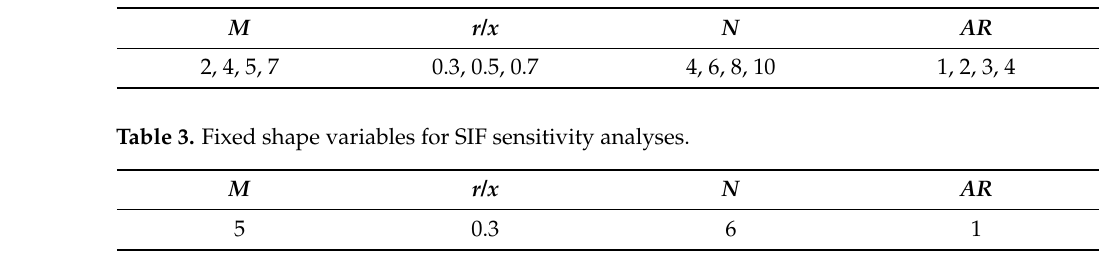
Table 2. Shape variables considered in the SIF sensitivity analyses.